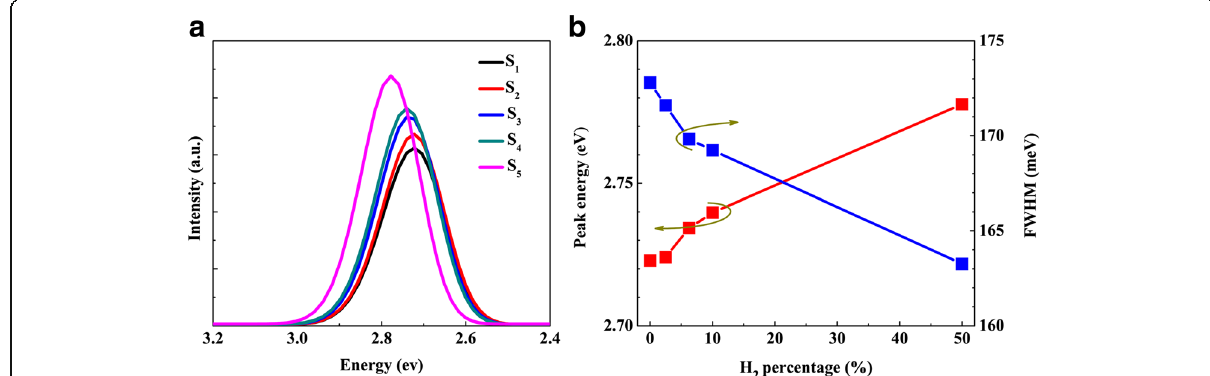
Fig. 6 a The measured room temperature PL spectra of the samples. b Gaussian-fitted FWHM and peak energy versus H 2 percentage in carrier